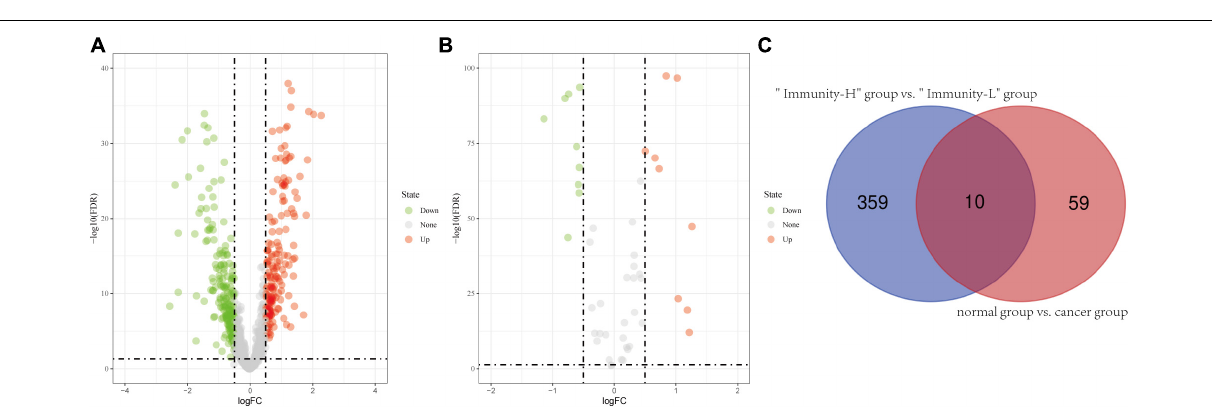
UCSC Xena website, we identified 69 differentially expressed lncRNAs between the cancer and normal groups, including 34 cancer group compared to the normal group ( Figure 2B ). A two-